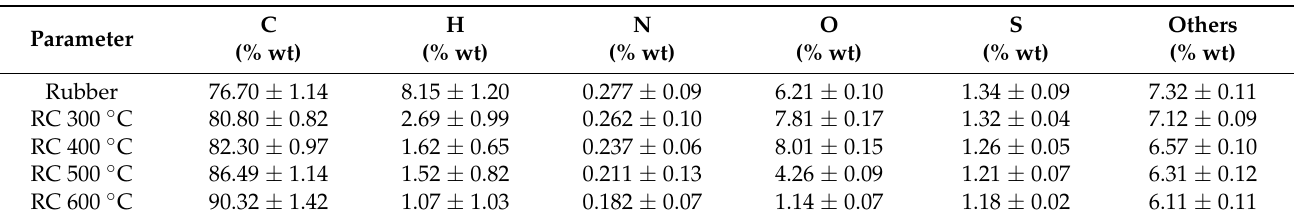
Table 3. Elemental analysis and mass loss average results of the carbonized rubber (RC) samples obtained (C—carbon; H—hydrogen; N—nitrogen; O—oxygen; S—sulfur). The values represent the